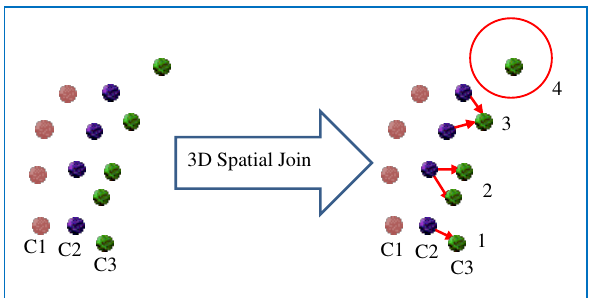
Figure 5. 3D spatial join between C2 and C3 points